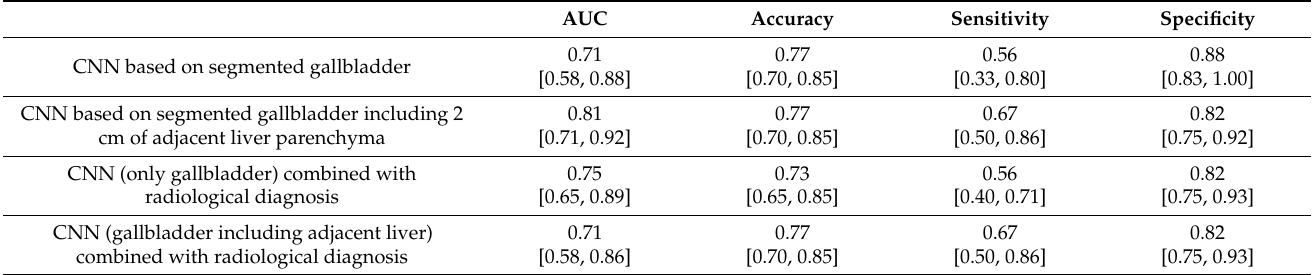
Table 2. Result of the convolutional neural network for differentiation between gallbladder cancer and benign gallbladder